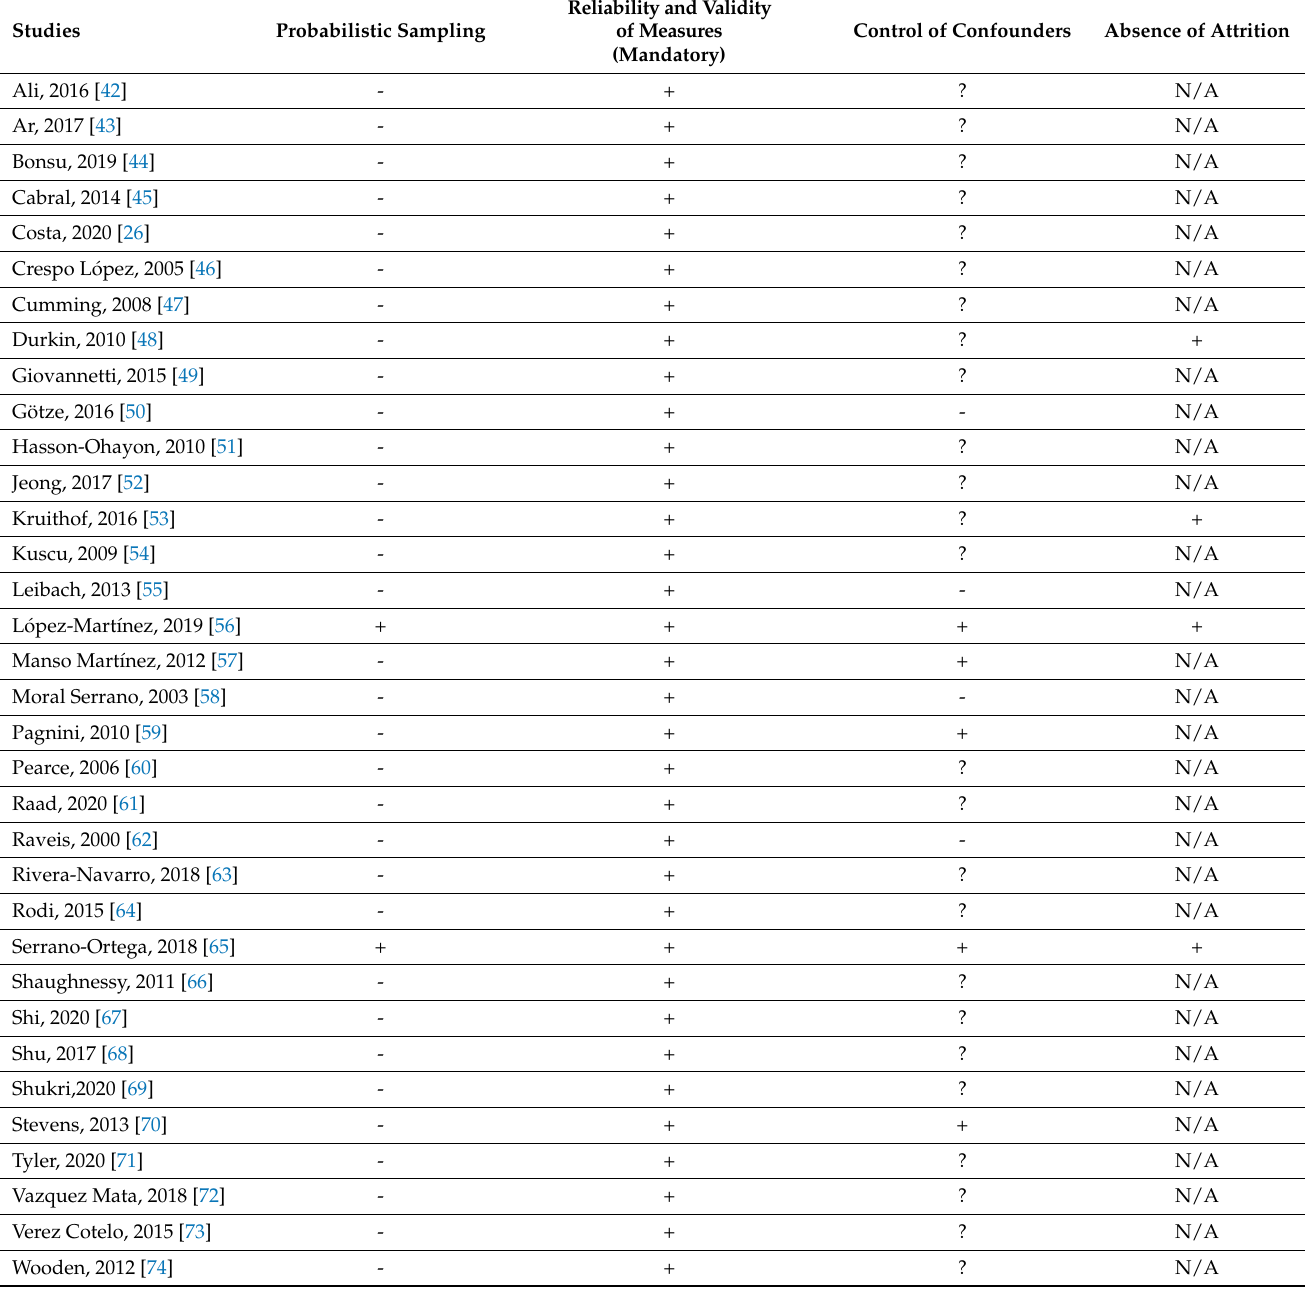
Table 2. Quality assessment of the included